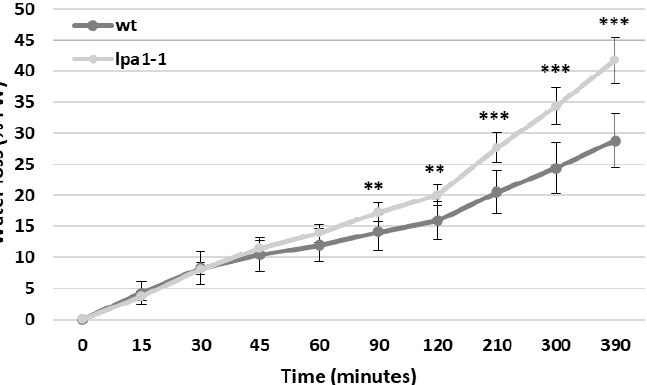
Figure 10. Percentage of water loss in the third detached leaf of homozygous lpa1-1 and wild-type. Values represent the mean of six biological replicates. Significant differences between wild-type and lpa1-1 were assessed by Student’s t -test (** p < 0.05 and *** p < 0.01).